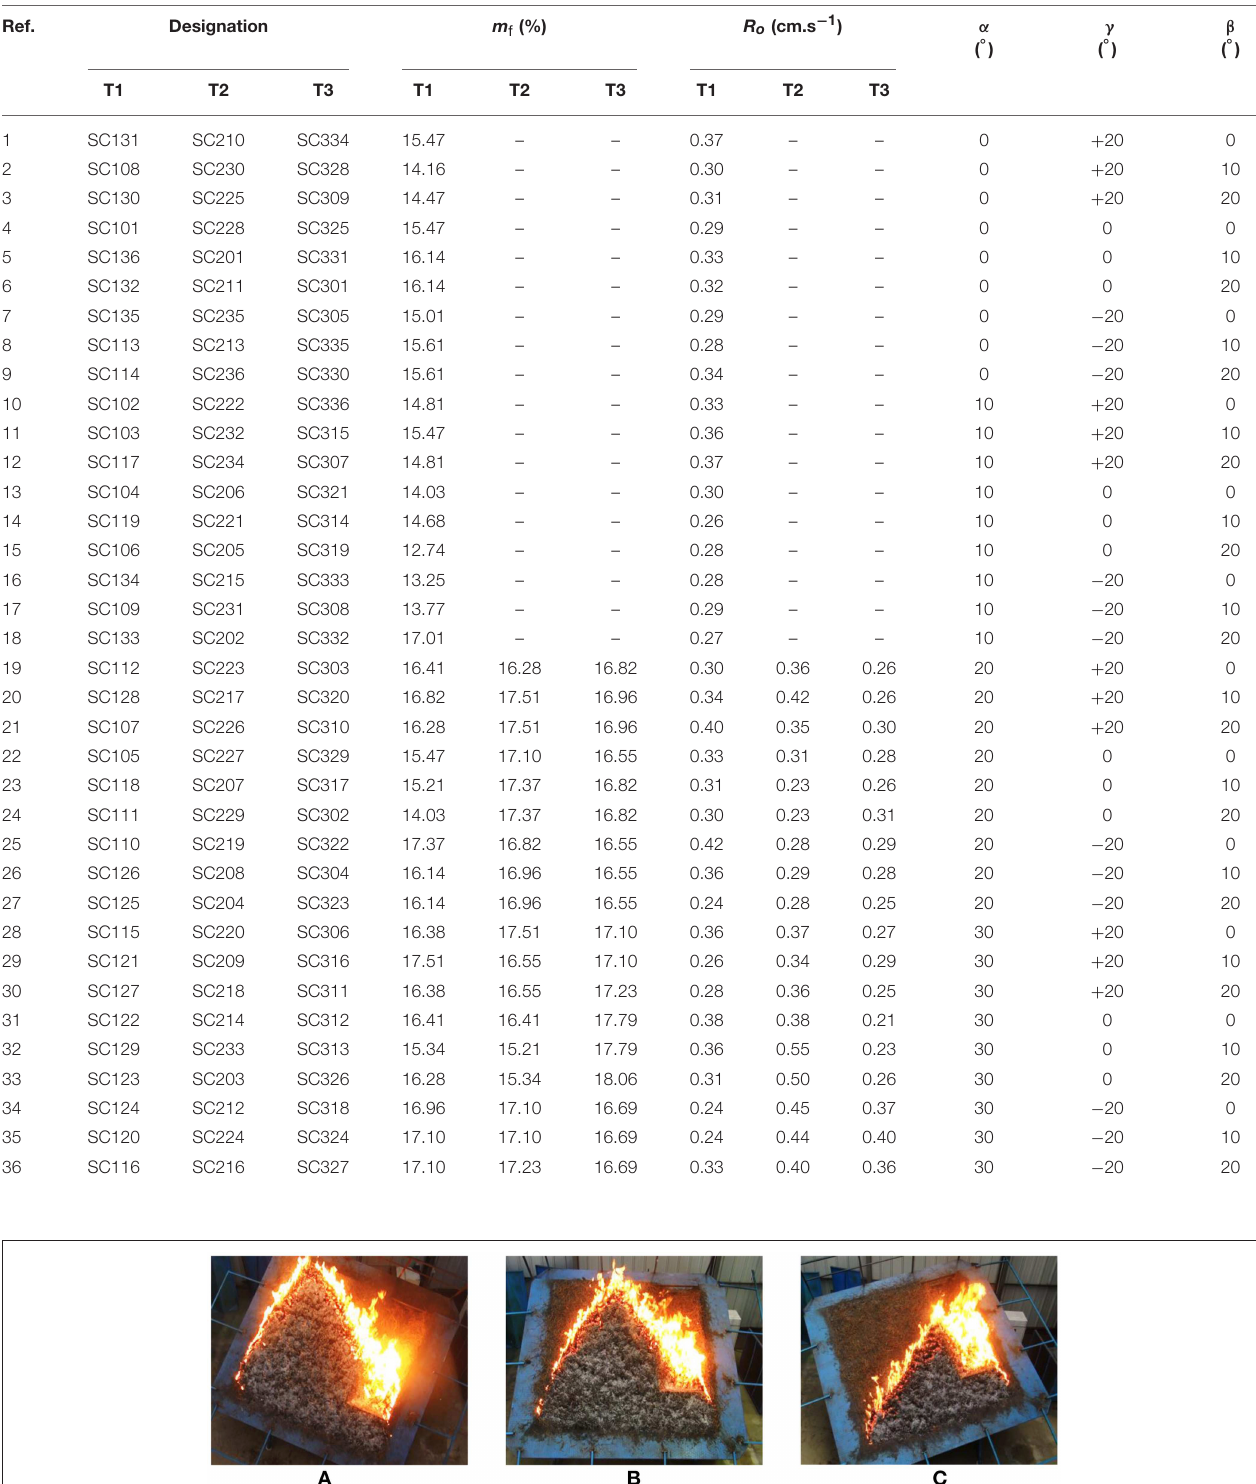
TABLE 2 | Data of the tests performed (for experiments with slope angles of α = 20 ◦ and α = 30 ◦ three tests were performed). Ref.